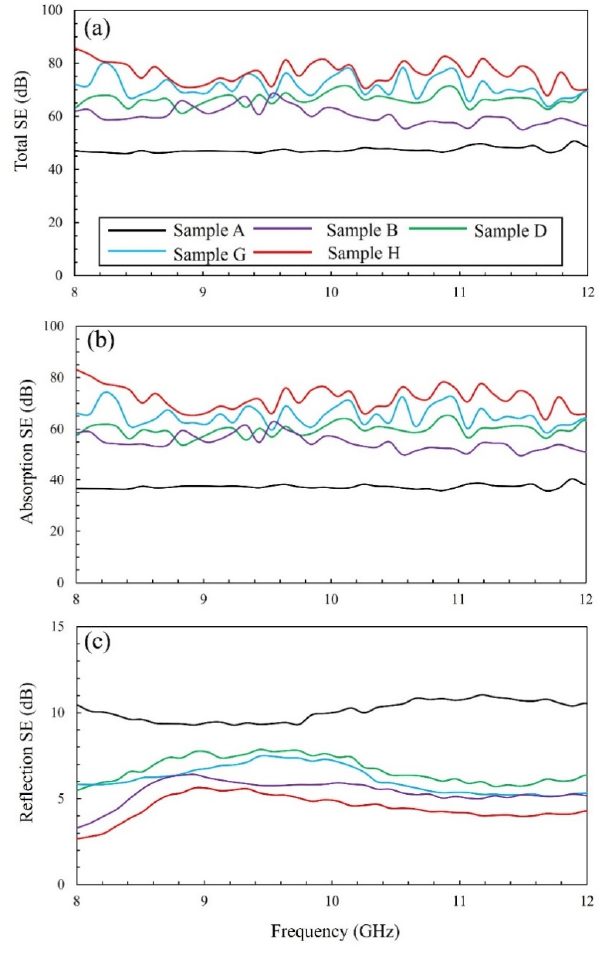
Figure 11. ( a ) Total SE spectra, ( b ) absorption component of the SE spectra, and ( c ) reflection component of the SE spectra for samples A, B, D, G, and H.